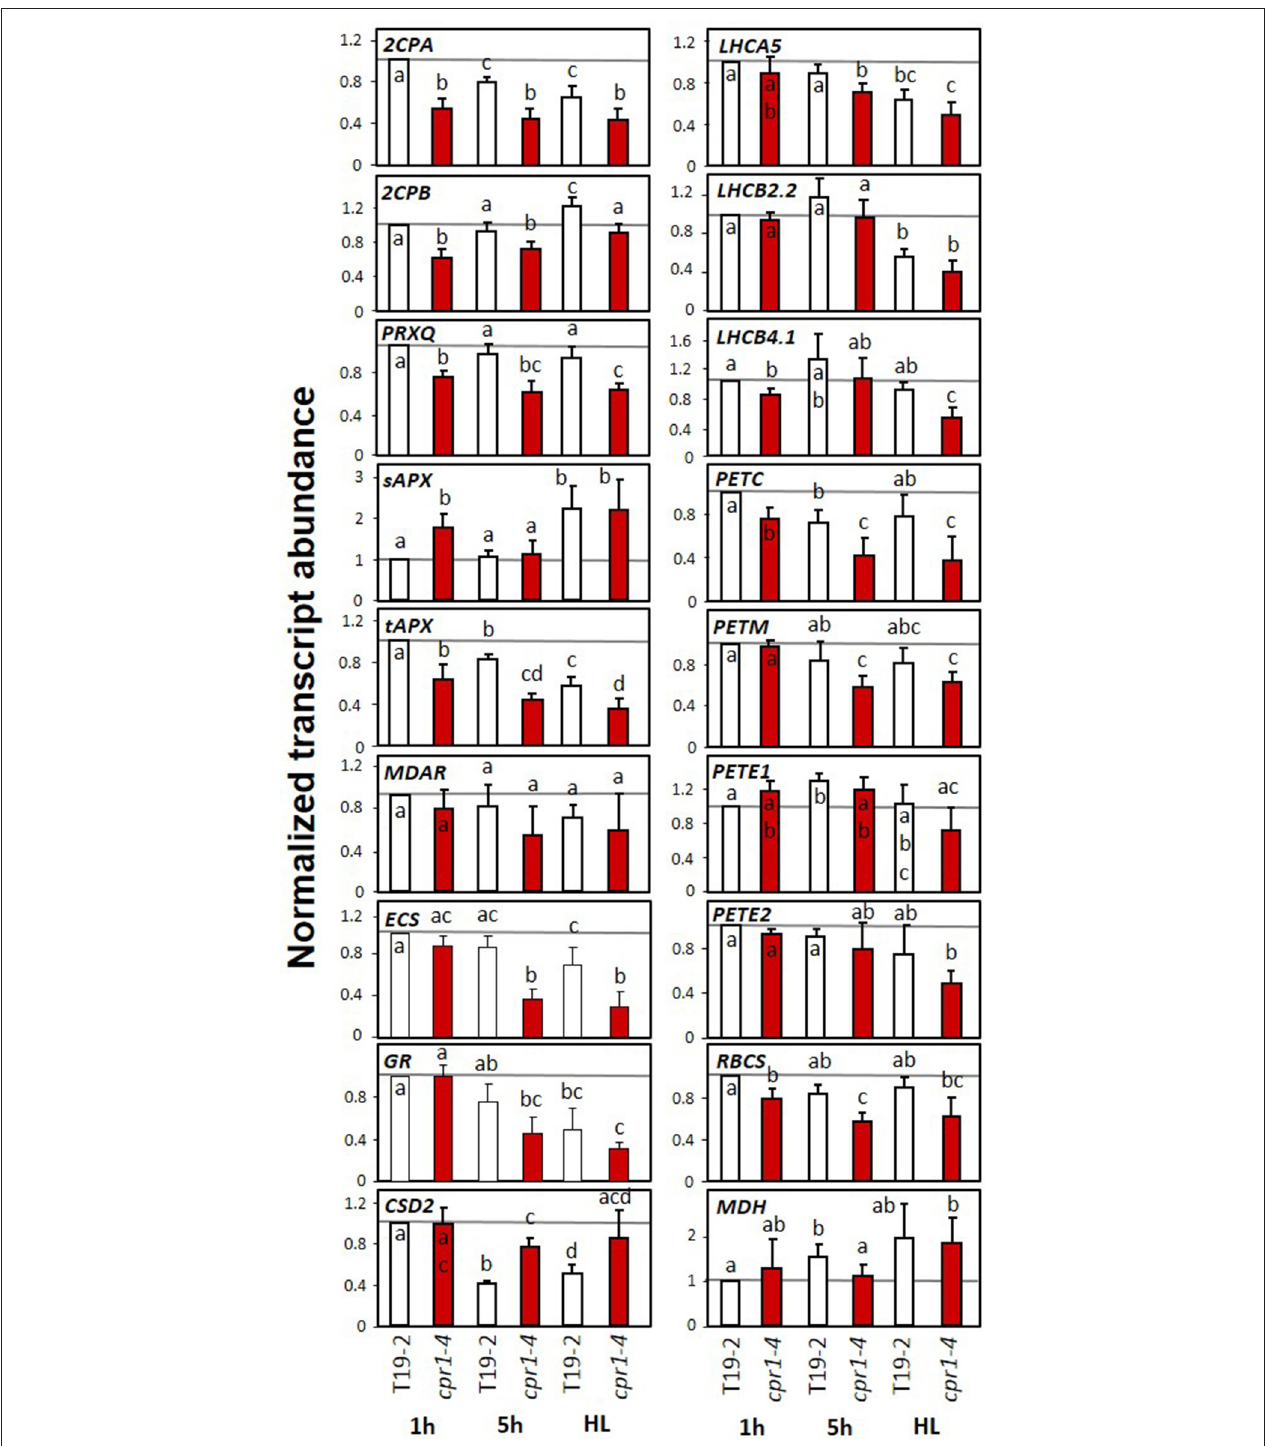
FIGURE 8 | Transcript levels of genes encoding chloroplast antioxidant enzymes, photosynthetic proteins, sugar related enzymes and marker genes for oxidative stress and wounding in 4-week old, sterile grown cpr1-4 and T19-2 in response to high light (HL). Four-week-old plants were harvested 1 and 5 h after exposure to 100 µ mol photons m − 2 s − 1 or after exposure to 800 µ mol photons m − 2 s − 1 (HL) for 4 h starting 1 h after the beginning of the light-phase. Bars represent the mean and standard deviation of four to seven biological replicates by qRT-PCR and normalized to actin2 ( At3g18780) transcript levels. Statistically significant differences are labeled with different letters (ANOVA, P <